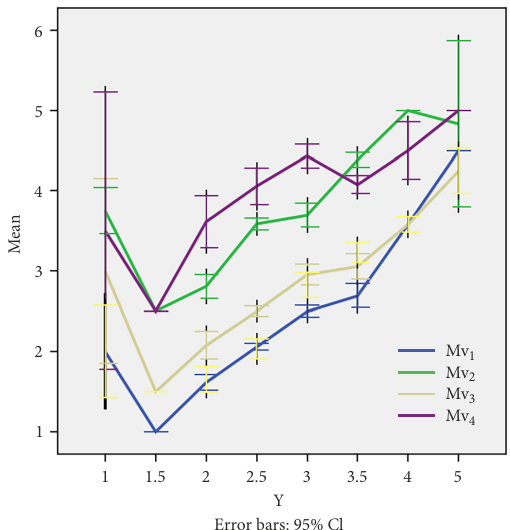
Figure 6. Dependant variable (Y) vs. independent variables (Mv 1–4 )